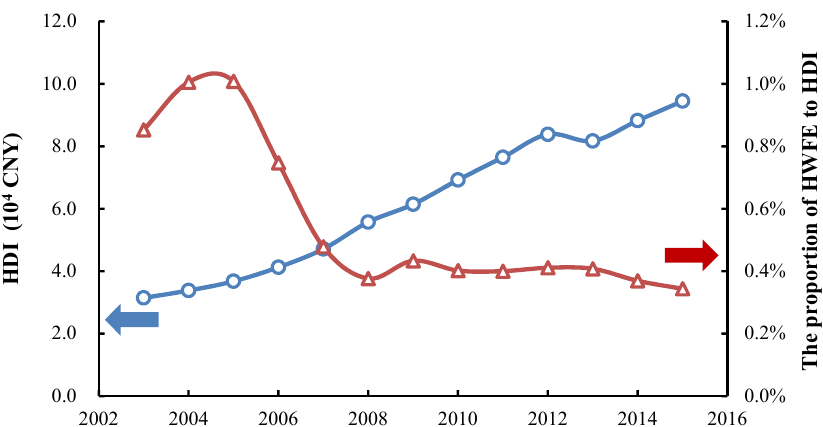
Figure 9. The curves of the HDI and the proportion of HWFE to HDI during the periods from 2003 to 2015.